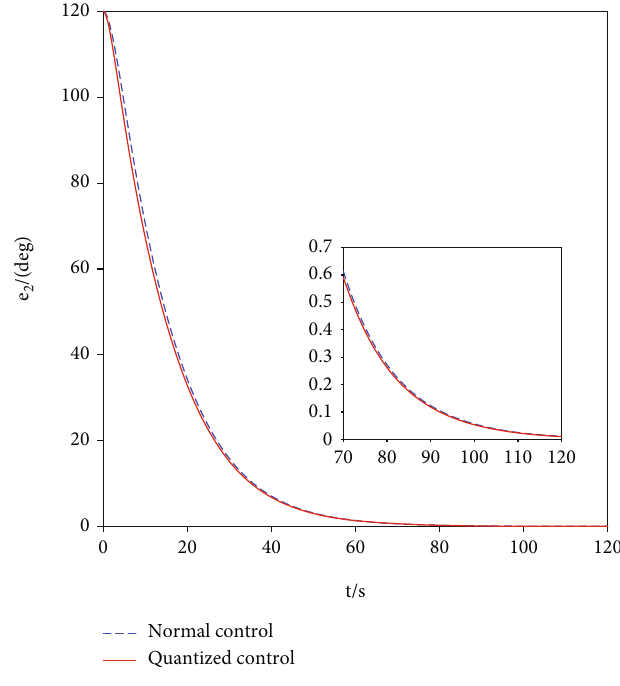
Figure 19: Relative attitude error curves.